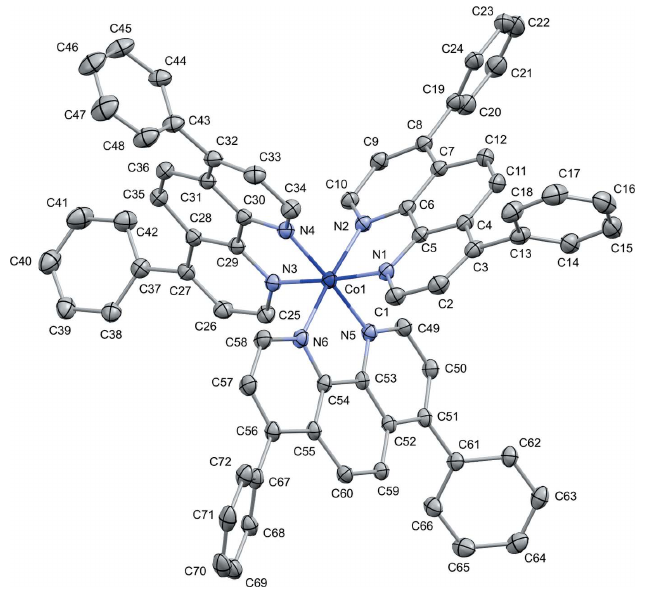
Figure 1 The molecular structure of the tris(4,7-diphenyl-1,10-phenanthroline)co- balt(III) cation of the title compound with displacement ellipsoids drawn at the 30% probability level. Hydrogen atoms are omitted for clarity.